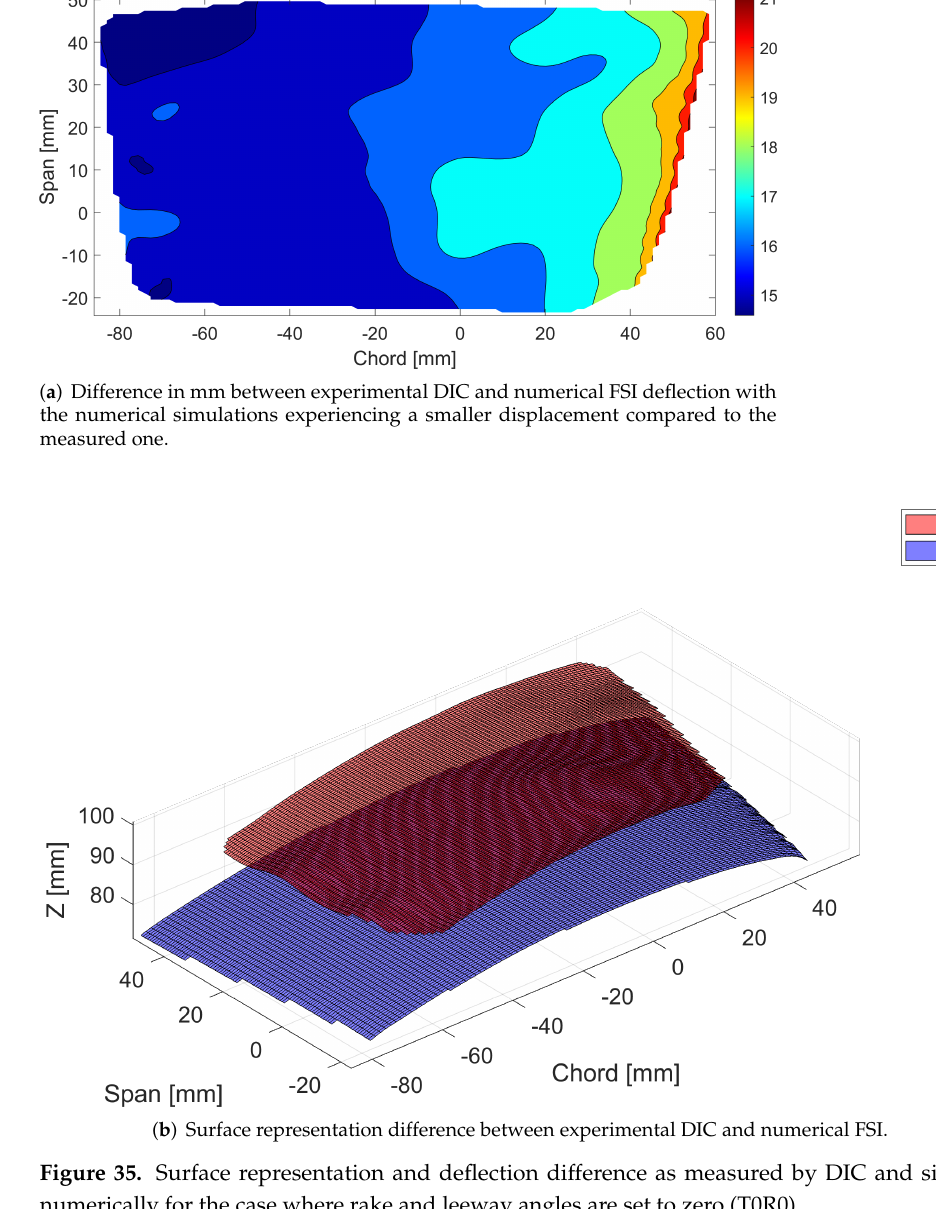
Figure 35. Surface representation and deflection difference as measured by DIC and simulated numerically for the case where rake and leeway angles are set to zero